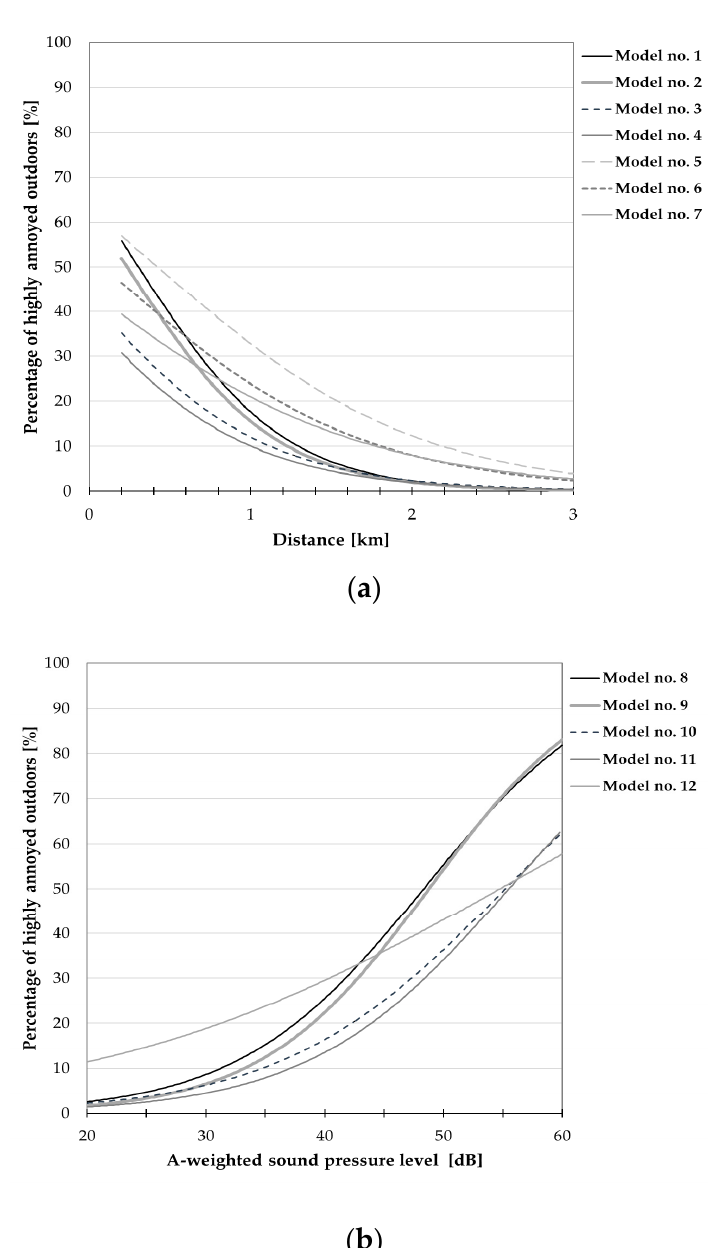
Figure 7. Relationships between the percentage of respondents being highly annoyed outdoors and ( a ) noise level or ( b ) distance from the nearest wind turbine. The curves correspond only to those models from Table 12 for which all regression coefficients reached a statistical significance; they were drawn, where applicable, with explanatory variables of “terrain shape” (=1), “sensitivity to noise” (=3) and “attitude to wind farms” (=2) equal to median values in the study group.